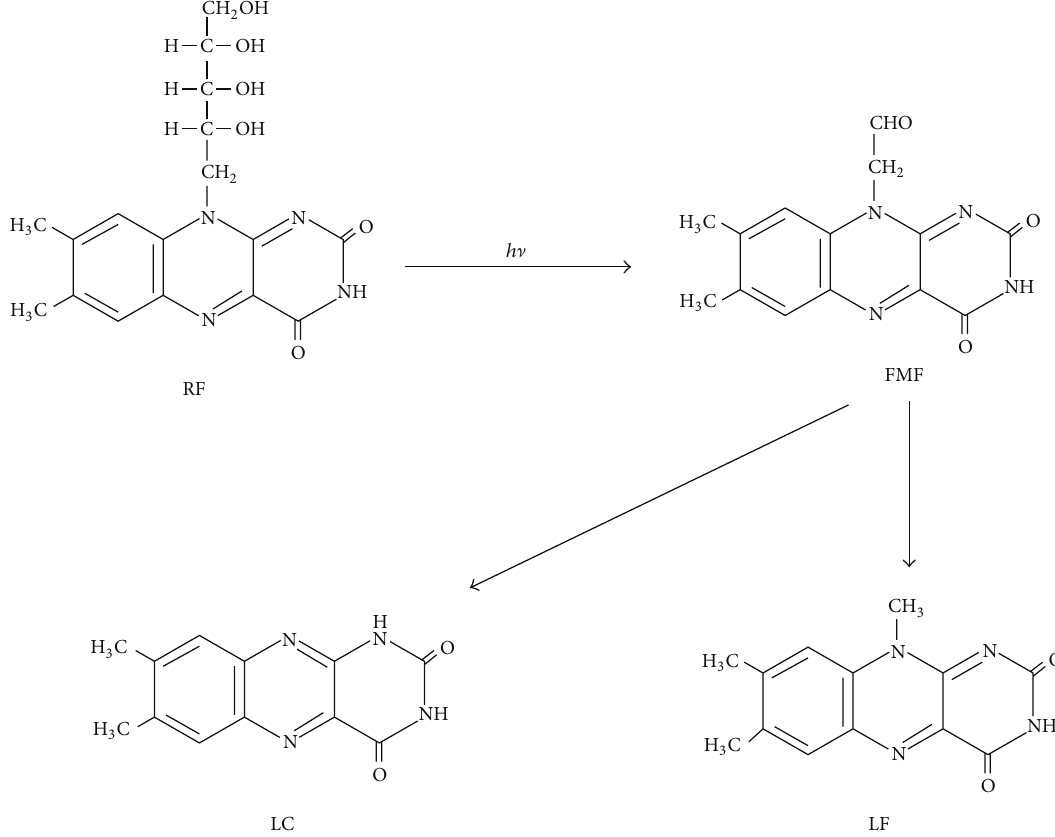
Figure 3: Scheme for the photodegradation of RF in alkaline